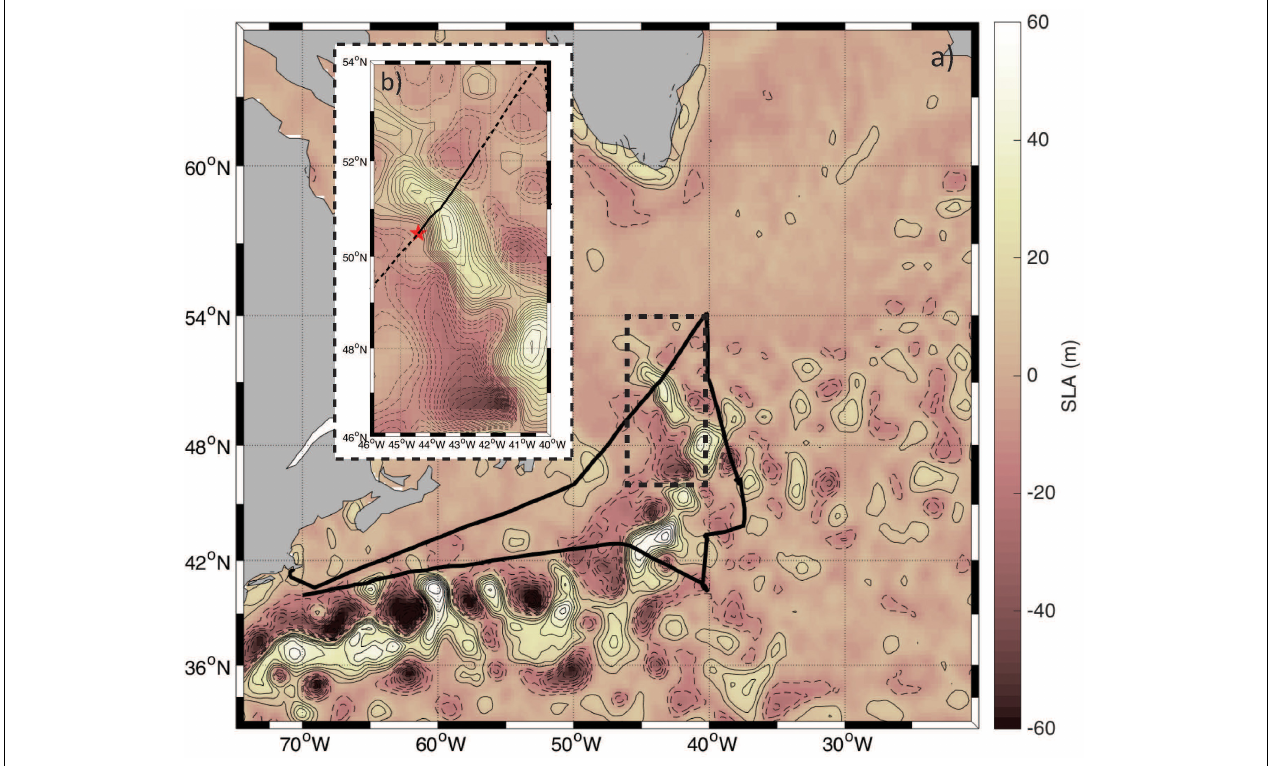
FIGURE 1 | (a) Psudo-color map of sea level anomaly (SLA) overlaid with contours at an interval of 7 cm in the NAAMES study region. Positive SLA (anticyclones) are shown in the solid contours and negative anomalies (cyclones) are displayed by dashed contours. The ship track is indicated by the solid black line and the region analyzed here is bounded in the black hashed box. (b) Zoomed in version of the map shown in panel (a) with a contour interval of 3 cm. The red star indicates the point from which the “Distance along track” is calculated and marks the first measurement collected on November 12, 2015. The solid black line highlights the data collected on November 12, 2015 with the hashed lines indicating data collected before and after this